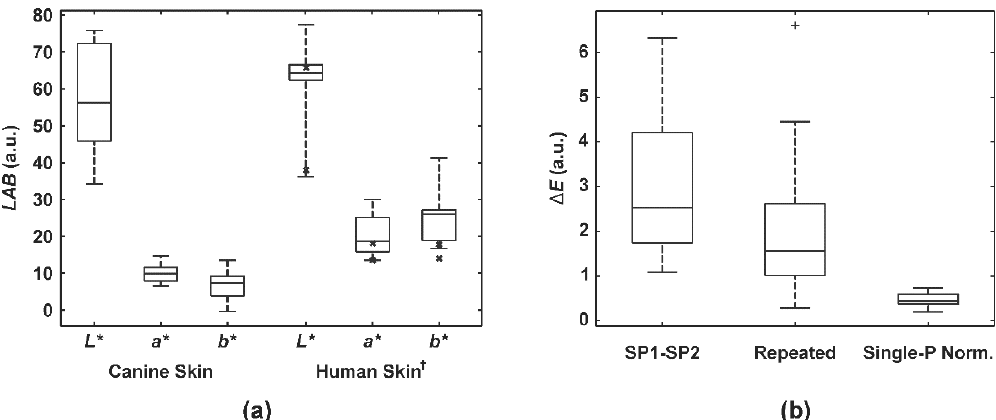
Figure 6. Clinical measurement of canine skin color. ( a ) Canine and human (full-range CCT: bold x-es, skin-range CCT: boxplots) skin color in the CIELAB color space. ( b ) Color differences ( ΔE ) in skin color between both smartphones’ estimates (SP1–SP2), between the original and repeated measurement (Repeated), and when a single-point normalization was applied (Single-P Norm.). Boxplots: the central mark represents the median; the bottom and top box edges indicate the 25th and 75th percentiles, respectively. Whiskers extend to the most extreme data point. The outlier is marked as a plus (+). († retrieved from the CCT specifications).